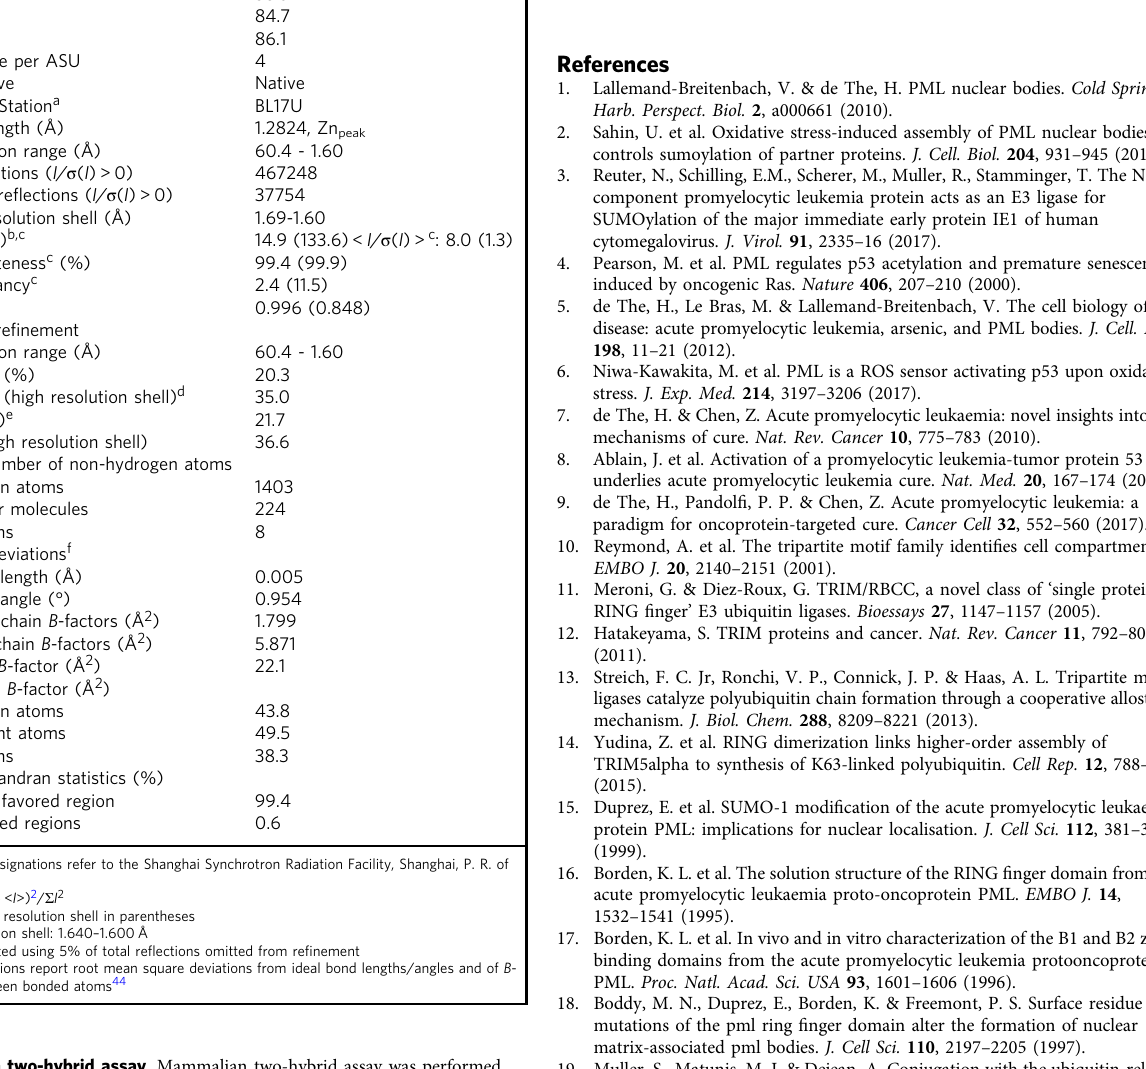
Table 1 Data collection and structure re fi nement statistics of PML-RING Data